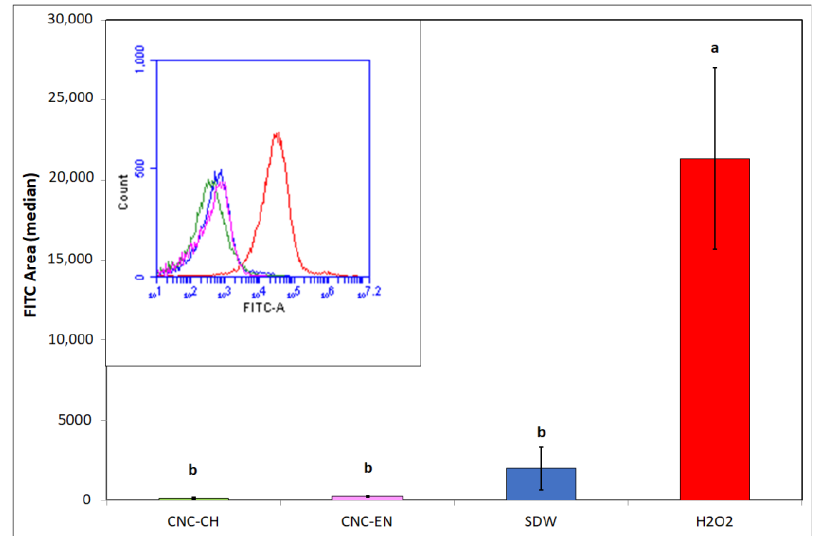
Figure 9. ROS production in Pto cells with exposition to 1% w/v CNC-CH, 1% w/v CNC-EN and 2% v/v H 2 O 2 after 12 h. Data represent the mean and standard deviation; different letters show signif- icantly different values after one- way ANOVA, followed by Tukey’s HSD post hoc test ( p < 0.05 ). The jar coagulation test revealed a very different behavior of bacterial cells when exposed to a suspension of 1% w/v CNC (Figure 10). After 3 h, aggregation level was equal to 78.5 and 80.8% for CNC-CH and CNC-EN, respectively, compared to the almost not aggregated control (phosphate buffer saline — PBS).